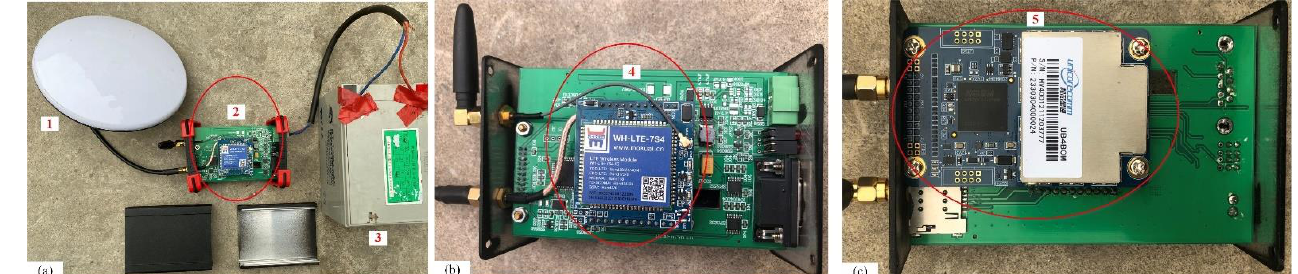
Figure 6. Low-cost GNSS receiver equipment. ( a ). Details of low-cost GNSS. ( b ). Installation of an- tenna equipment connects the antenna and main cable. ( c ). GNSS antenna dome.